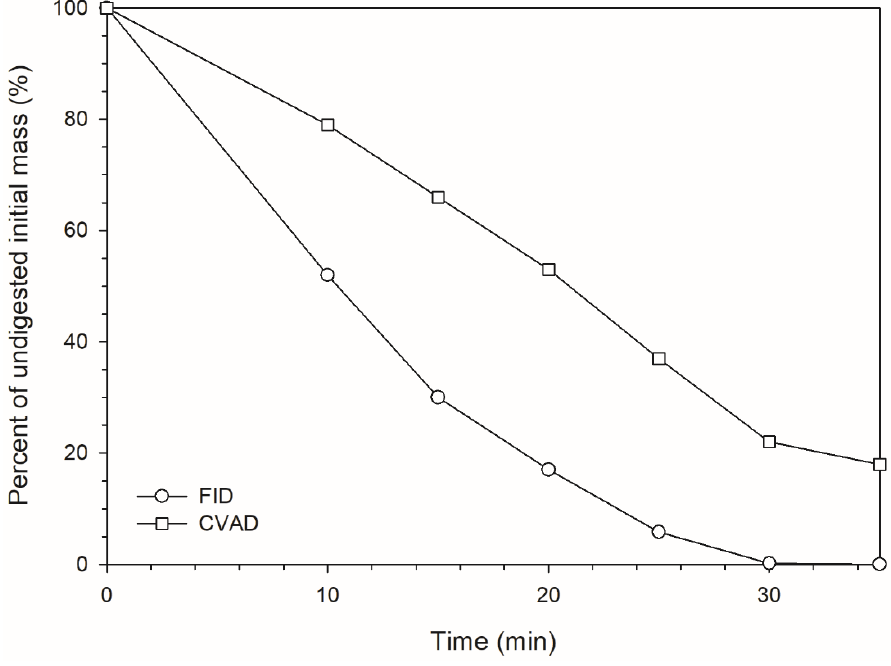
Figure 4. Undissolved magnet mass percentage after digestion in H 2 SO 4 by FID and